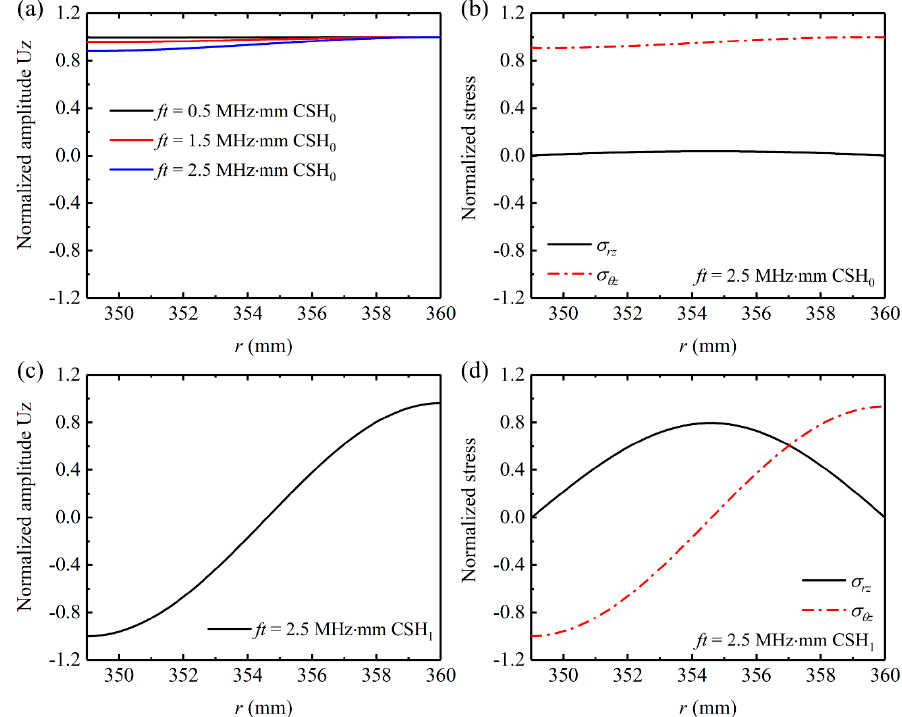
Figure 3. Wave structures and stresses of CSH waves in a steel pipe (outer diameter 720 mm, wall thicknesses 11 mm, Young’s modulus 210 GPa, density 7850 kg/m 3 and Poisson’s ratio 0.33): ( a ) particle displacement distributions of CSH 0 wave at different frequencies, ( b ) stress components σ θ z and σ rz of CSH 0 wave at 2.5 MHz·mm, ( c ) particle displacement distribution, ( d ) stress components of CSH 1 wave at 2.5 MHz·mm.